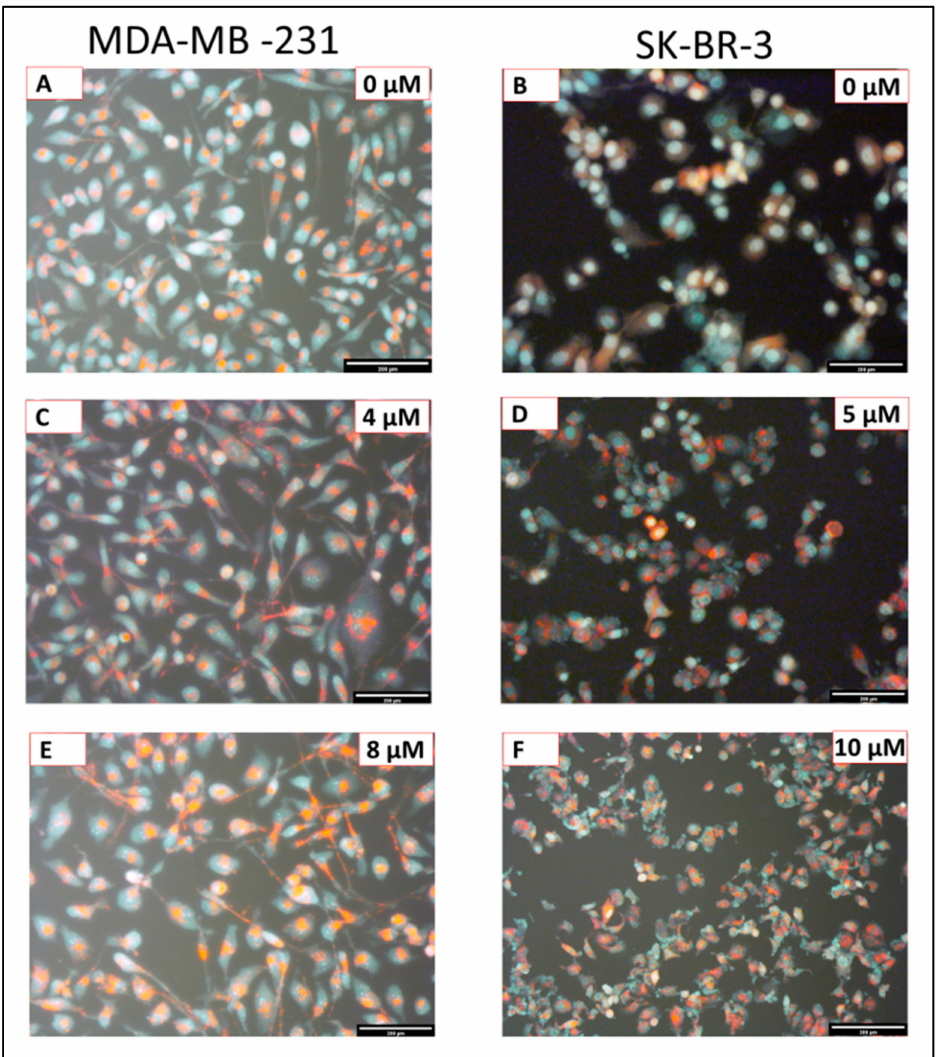
Figure 3. Fluorescence images of MDA-MB-231 and SK-BR-3 cells exposed to different eugenol concentrations stained with Acridine Orange (AO) under blue light excitation: untreated MDA- MB-231 ( A ) and SK-BR-3 ( B ) cells; MDA-MB-231 ( C ) and SK-BR-3 ( D ) cells treated with 4 µ M and 5 µ M eugenol for 24 h, respectively; MDA-MB-231 ( E ) and SK-BR-3 ( F ) cells treated with 8 µ M and 10 µ M eugenol for 24 h, respectively. Red fluorescence indicated autophagic vacuoles, while green fluorescence indicates the presence of nuclei. Magnification: × 10; scale bar: 200 µ